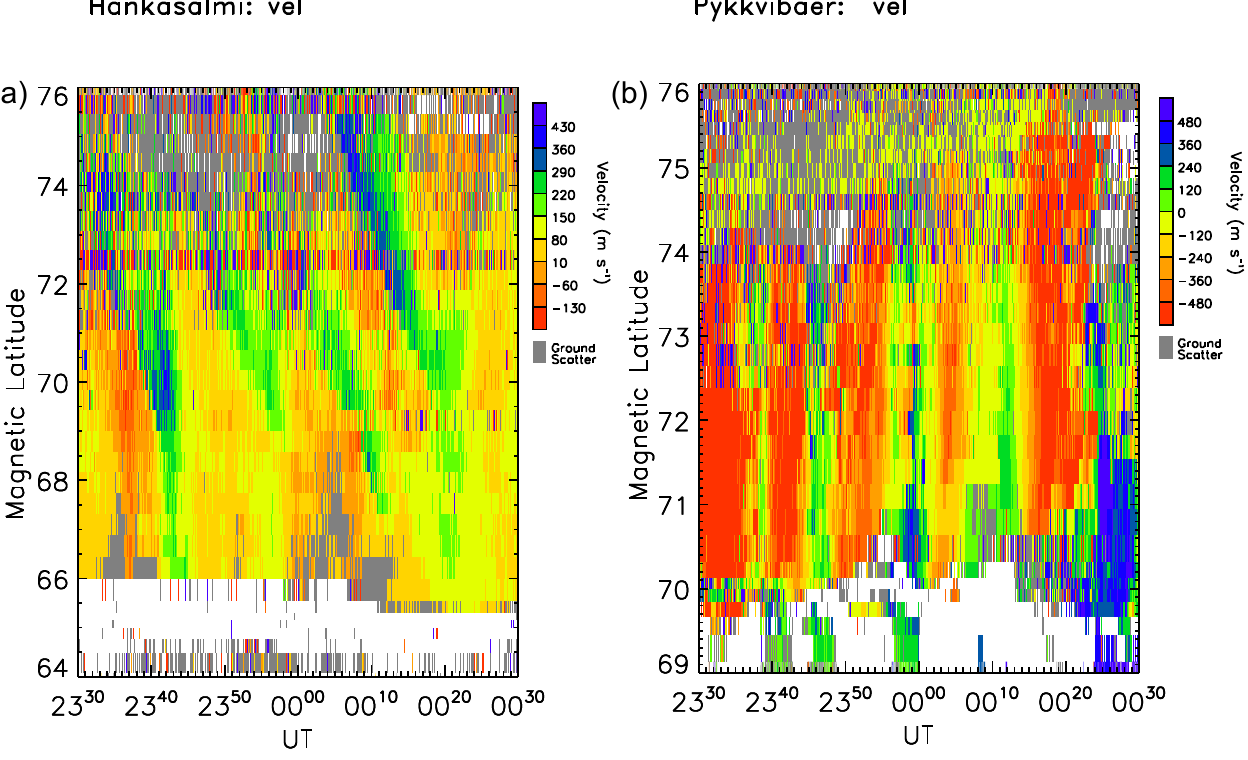
Fig. 4. SuperDARN radar velocity measurements from (a) Hankasalmi beam 9 and (b) Þykkvibær beam 5. The ionospheric velocities are colour-coded as in Fig. 2, and the location of these two high time resolution beams is illustrated in Fig. 1.